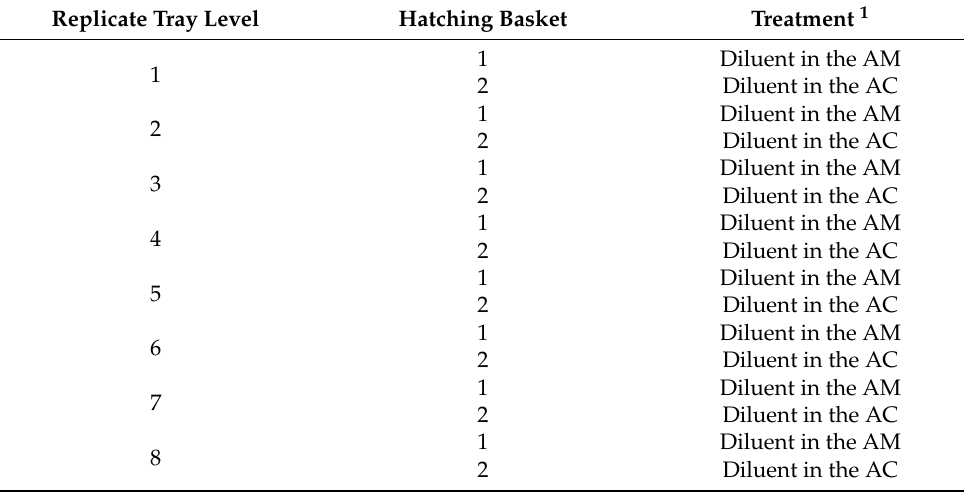
Table 3. Experimental design in the hatchery unit containing eggs belonging to treatments in which diluent was injected into either amnion ( AM ) or air cell ( AC